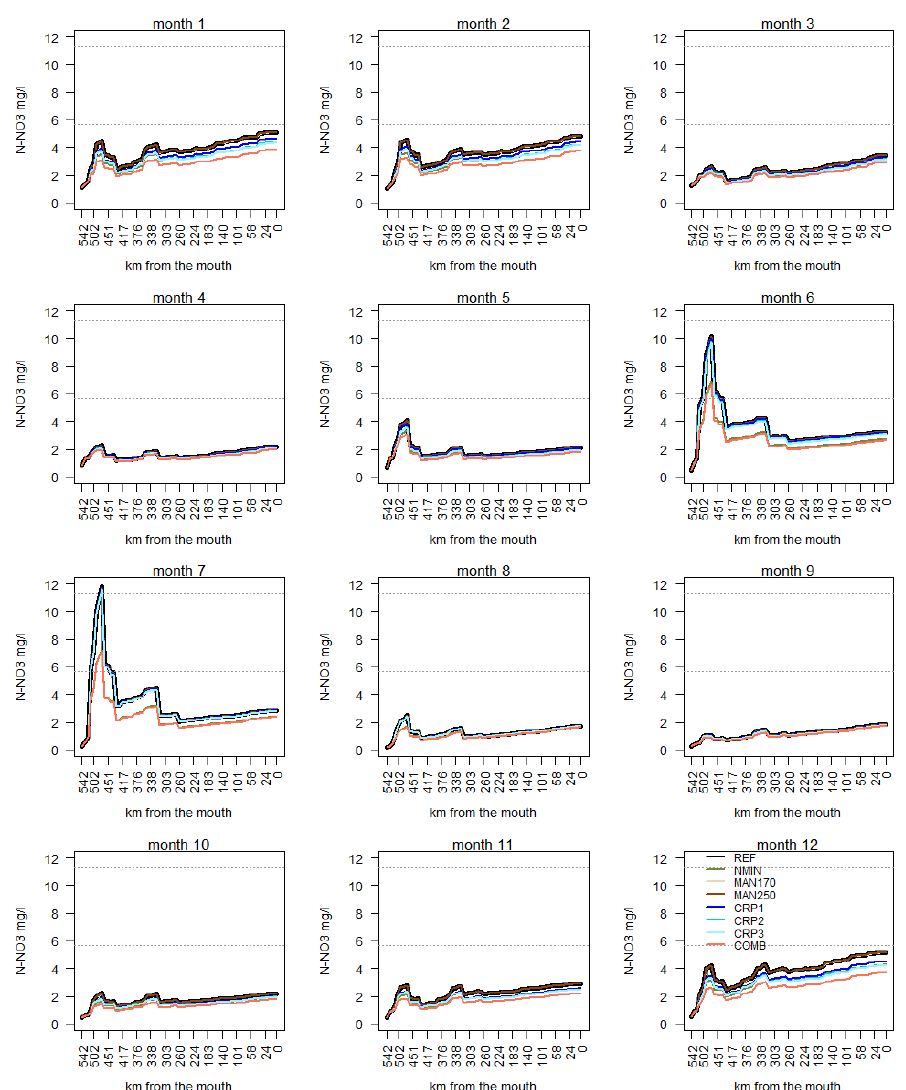
Figure A1. Monthly analysis of simulated N-NO 3 concentrations in the period 2000–2012 as function of the distance from the mouth. The horizontal grey lines represent the limits of 5.6 mg N/L (or 25 mg/L) and 11.3 mgN/L (or 50 mg/L).